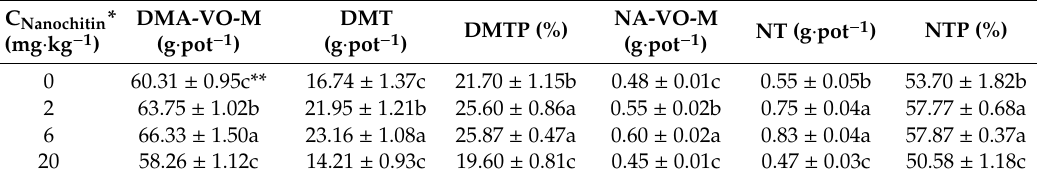
Table 3. E ff ects of nanochitin on dry matter and N retranslocation from pre-anthesis vegetation organs to grains.